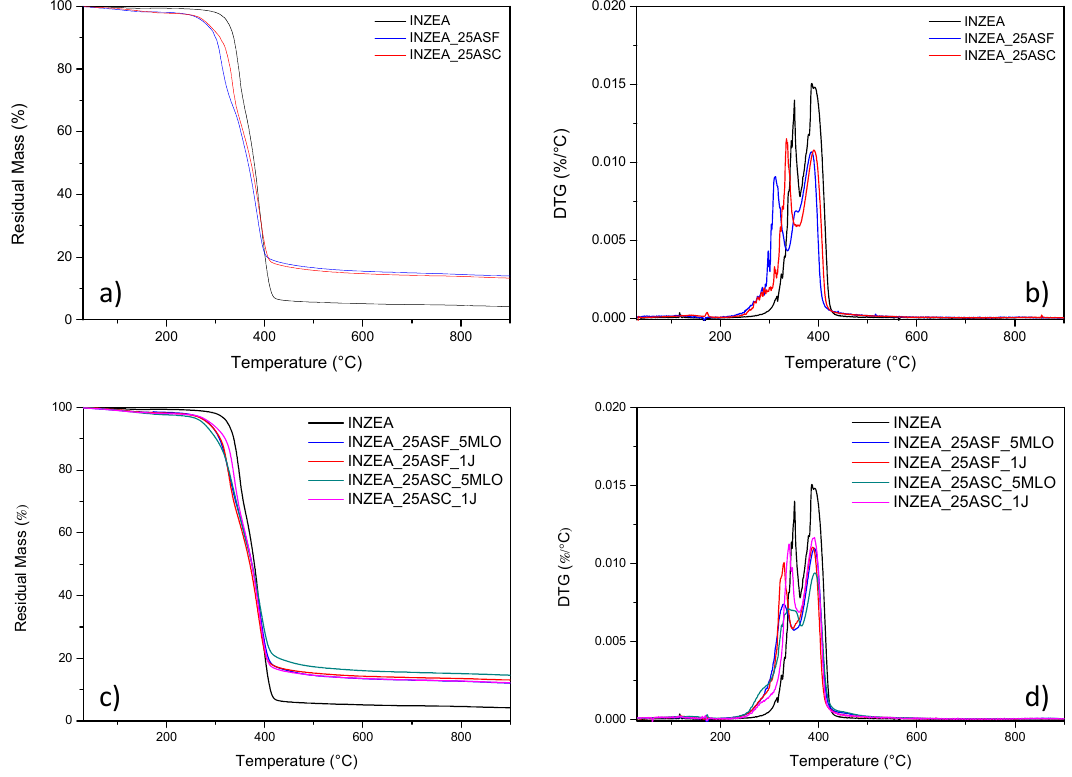
Figure 5. TG / DTG curves of INZEA-based biocomposites with 25 wt % of ASP at the two grinding levels ( a , b ) and INZEA biocomposites with 25 wt % of ASP in the presence of MLO or Joncryl compatibilizers ( c , d ).